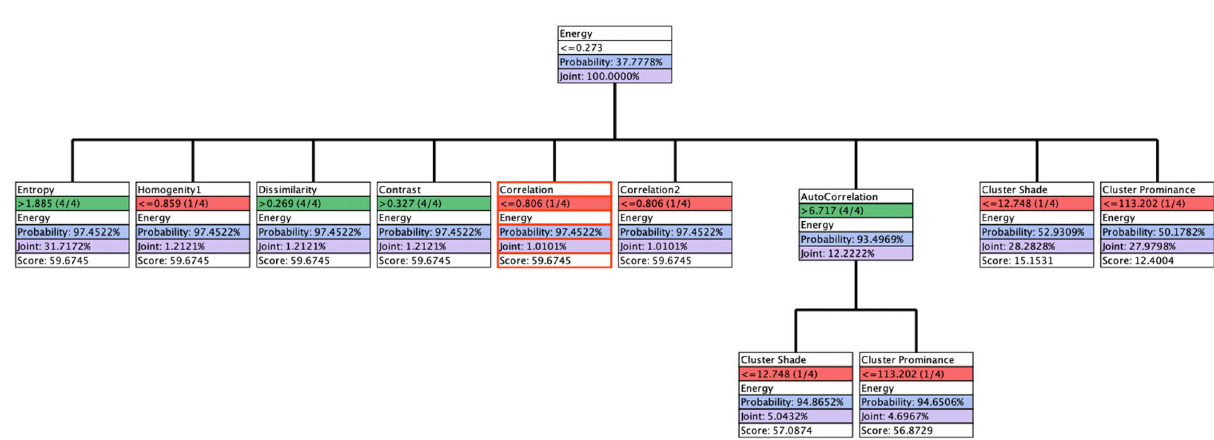
Figure 10. Tree optimization of GLCM energy as target